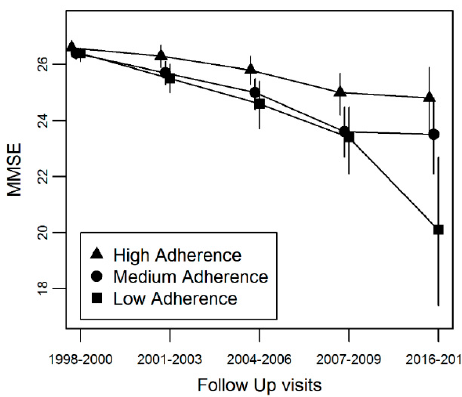
Figure 1. Trajectories of MMSE by Mediterranean Diet Score groups. The graphs display the mean MMSE at baseline and four follow up visits. The high adherence group (triangle) has the least decline in MMSE over time, followed by the medium adherence group (circle) and the low adherence group (square).